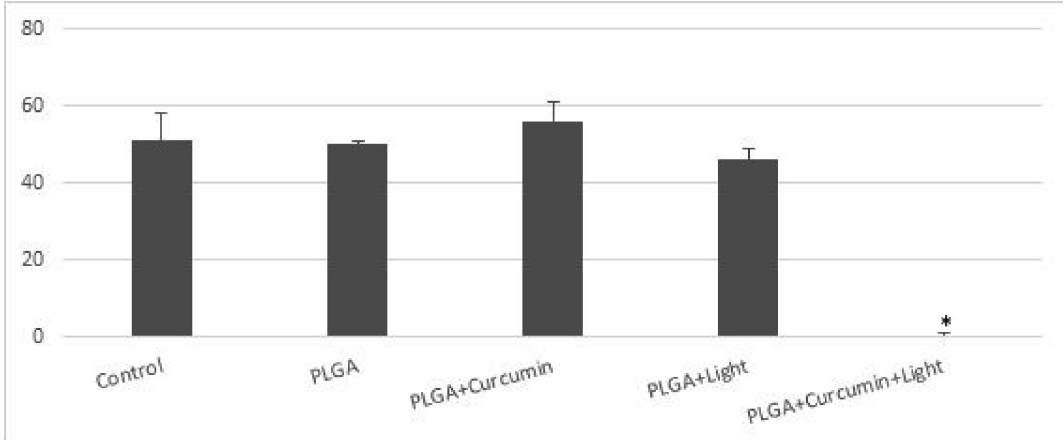
FIGURE 4 - Effect of antimicrobial photodynamic therapy (aPDT) with PLGA NPs against Criptococcus neoformans ATCC 90112 for each of the following treatment groups: control (no NPs and no light), PLGA (empty NPs without light), PLGA+curcumin (NPs without light), PLGA+light (empty NPs with light), and PLGA+curcumin+light (aPDT). C. neoformans was cultivated in Sb agar (control). The treatments were performed at the exposure time of 1